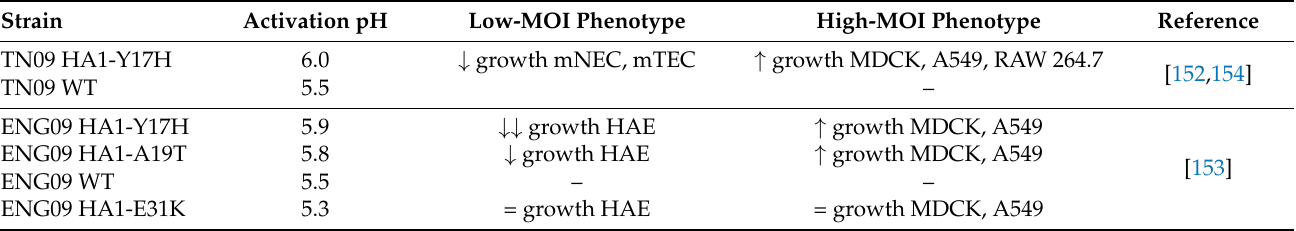
Table 3. Phenotypes of A/Tennessee/1-560/2009 (H1N1) and A/England/195/2009 (H1N1) HA stability variants in vitro.